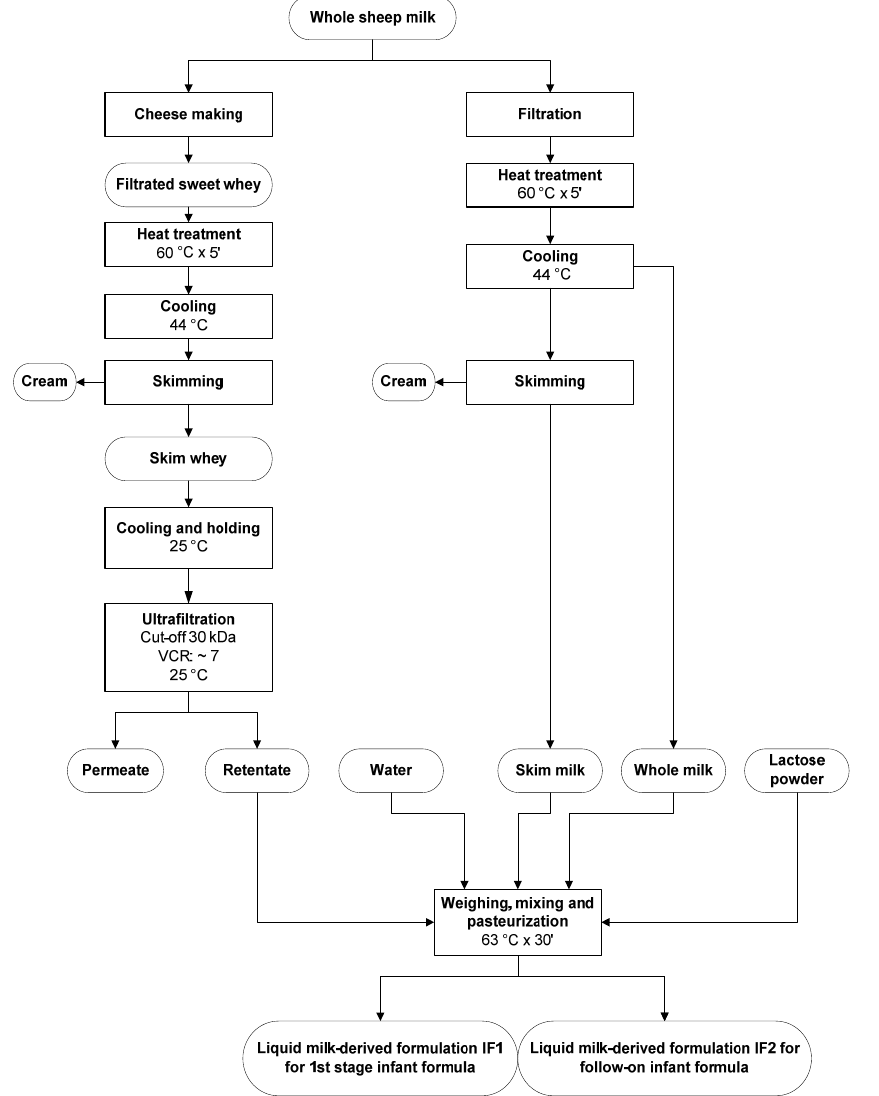
Figure 1. Flow chart of the production process of liquid milk-derived formulations IF1 and IF2 to be used in the production of first stage (from 0 to 6 months of age) and follow-on (from 6 to 12 months of age) infant formulae, respectively. VCR = volumetric concentration ratio.